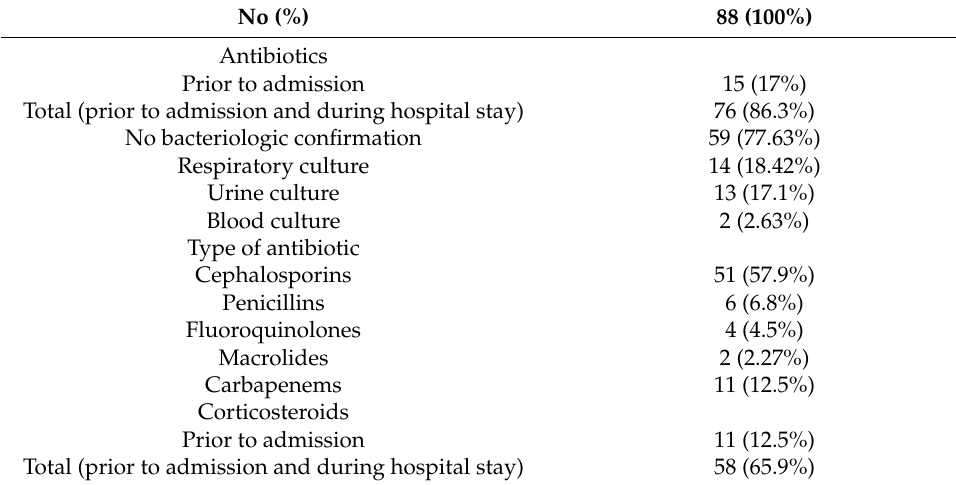
Table 2. High-risk medication in CDI-COVID-19